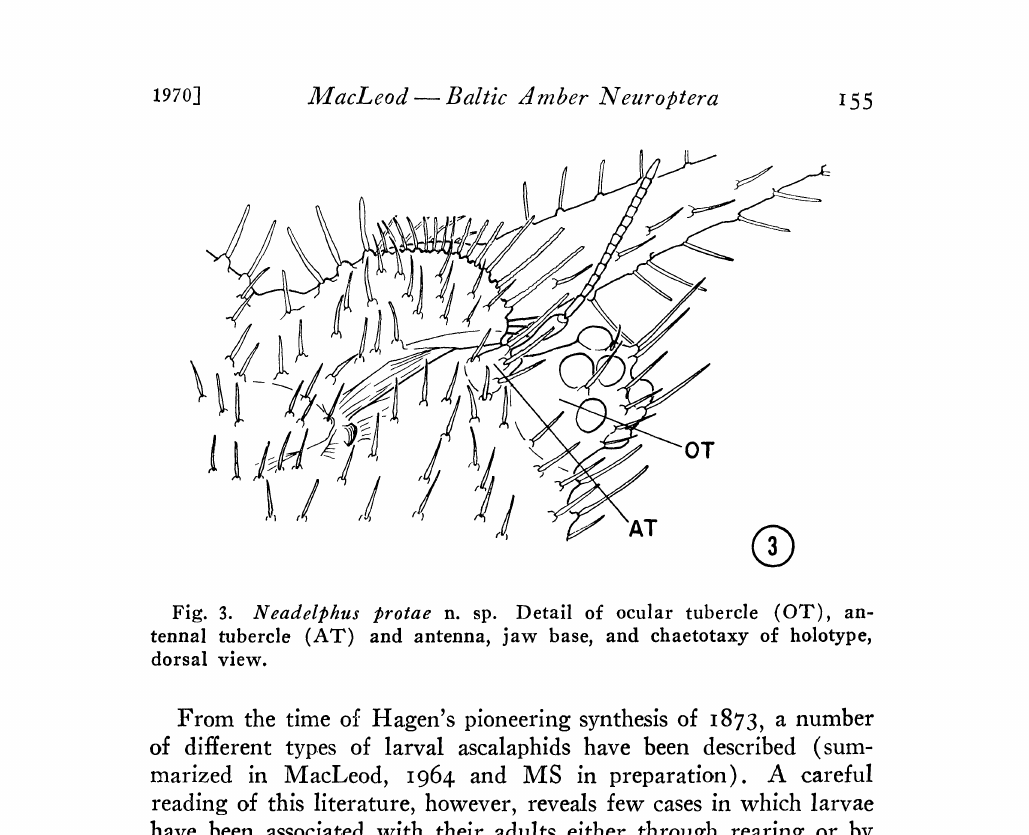
Fig. 3. Neadelphus protae n. sp. Detail of ocular tubercle (OT), an- tennal tubercle (AT) and antenna, jaw base, and chaetotaxy of holotype, dorsal